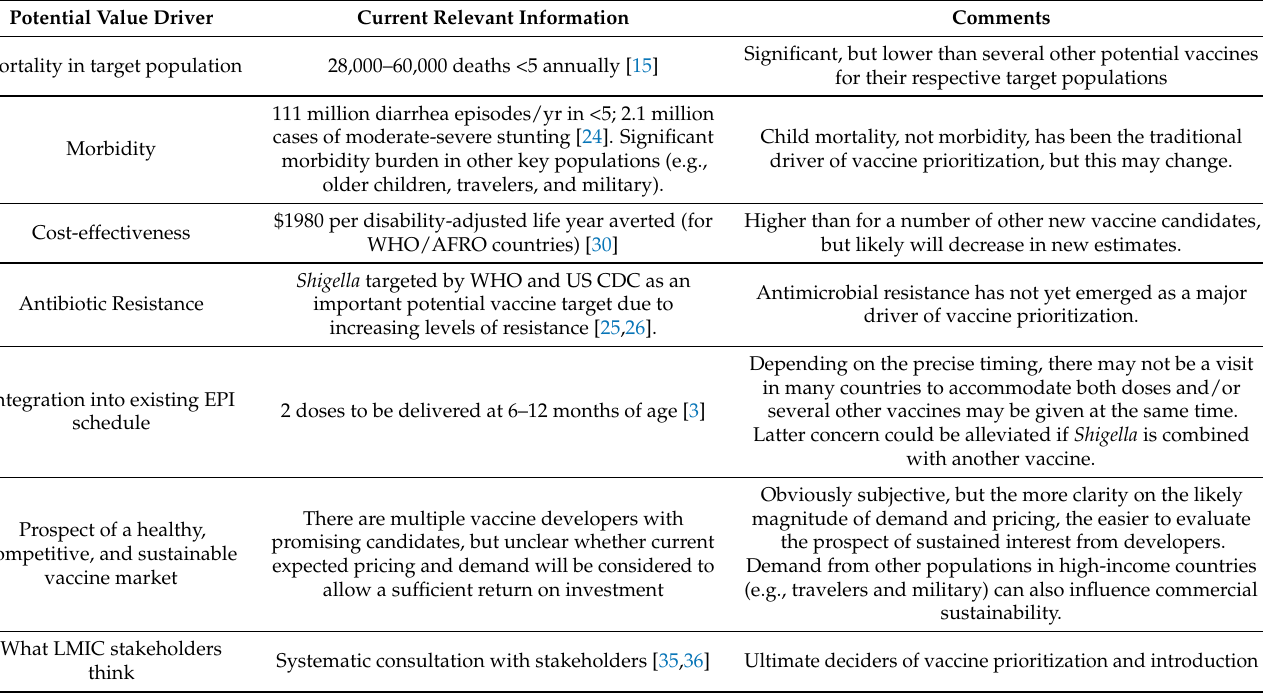
Table 1. Some potential determinants of Shigella vaccine value in the context of competing interven-